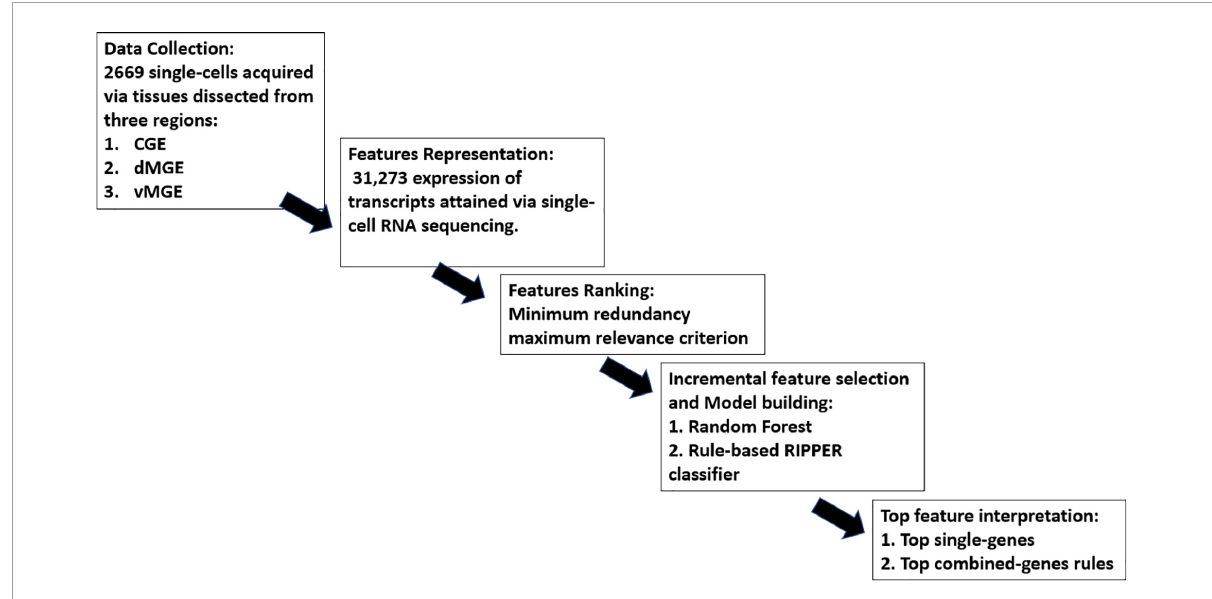
FIGURE1 Overall workflow of the